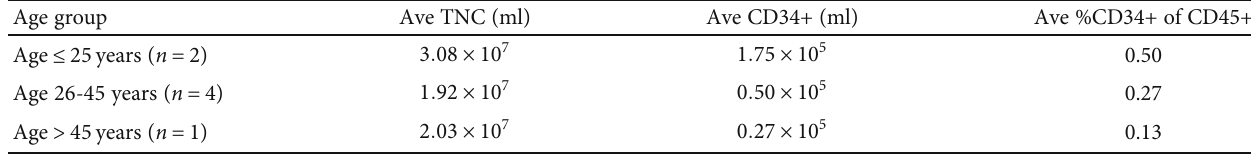
Table 2: Distribution of HSC in deceased donor iliac crest bone marrow based on age ( n = 7 ).